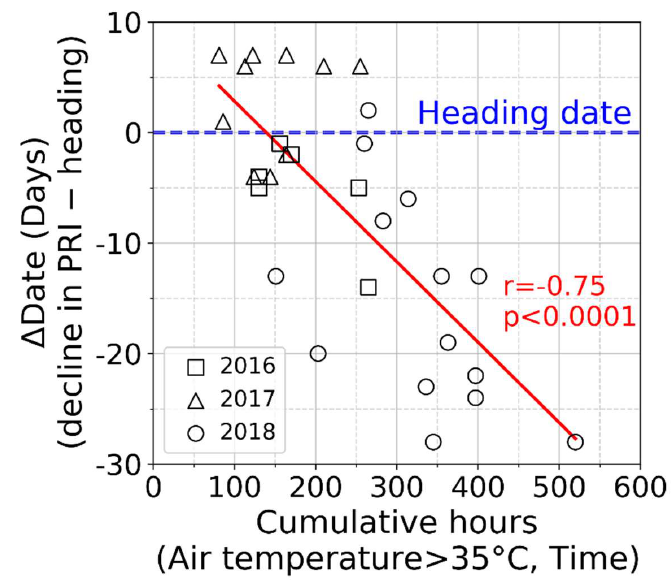
Figure 8. Relationship between cumulative hours when the air temperature is above 35 °C and delta date (decline date in PRI – heading stage date). Red line indicates the trend line of scatter plots measured for three years.